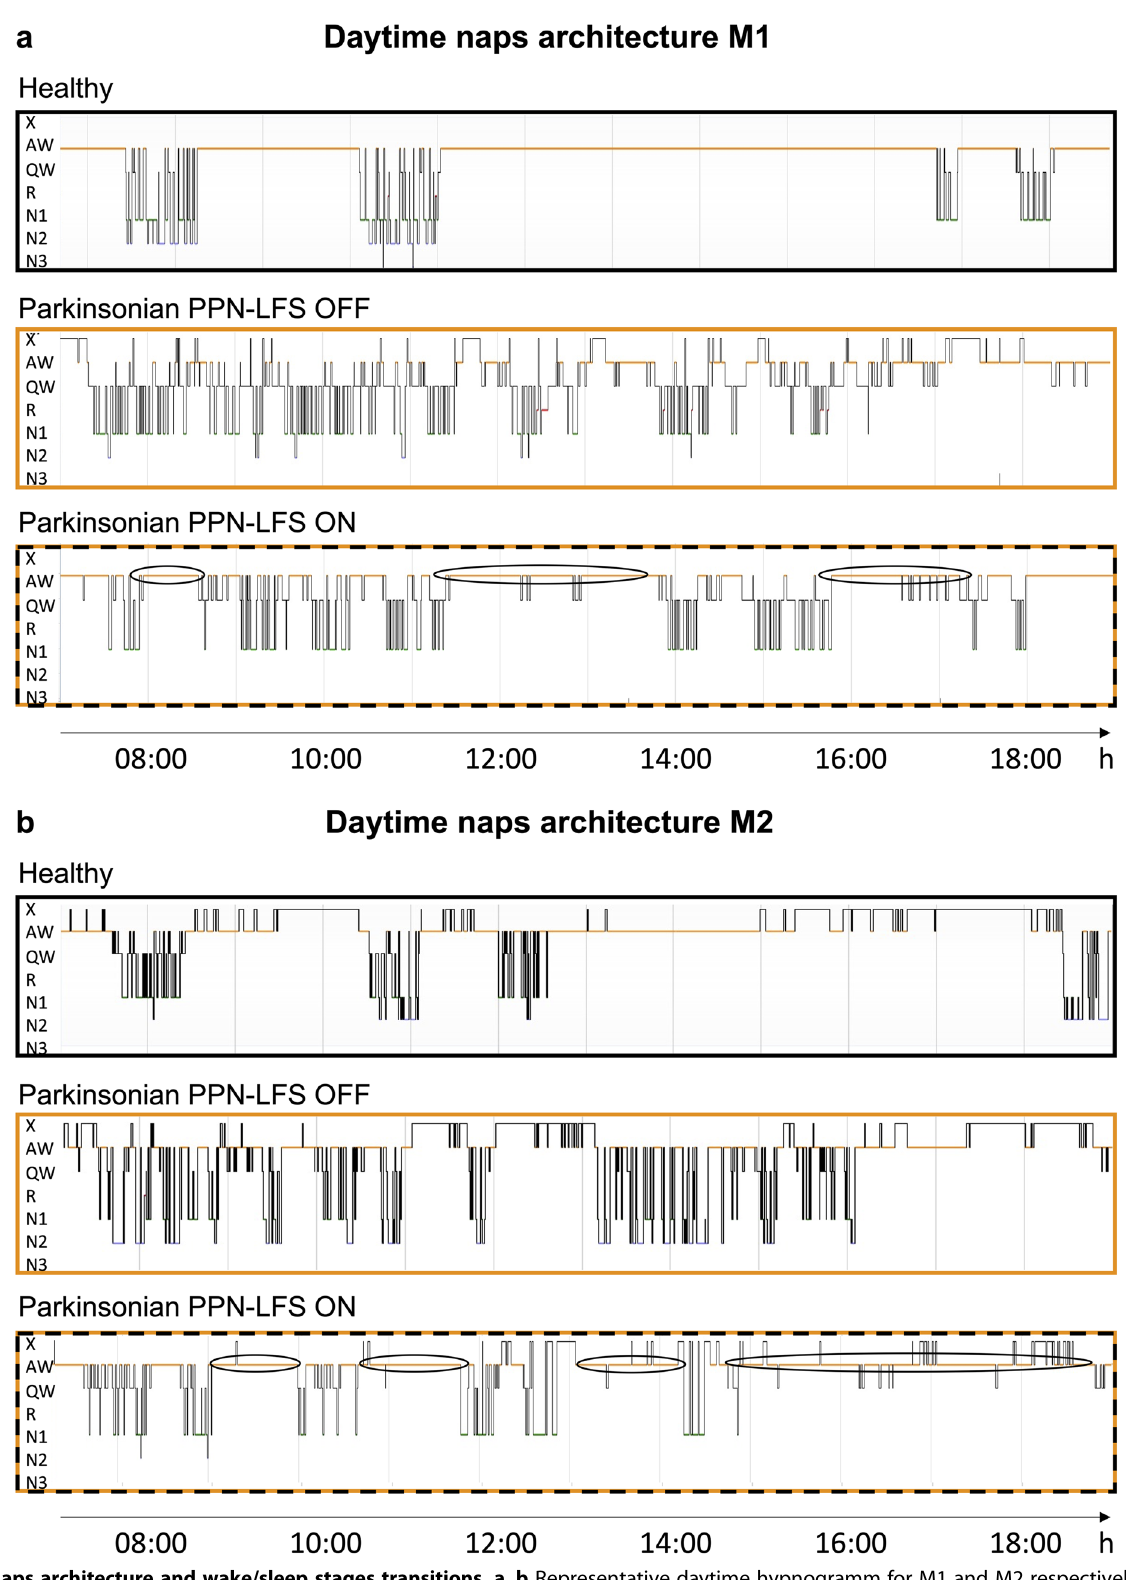
Fig. 3 Naps architecture and wake/sleep stages transitions. a , b Representative daytime hypnogramm for M1 and M2 respectively, during healthy, parkinsonian PPN-LFS OFF and parkinsonian PPN-LFS ON conditions. The line position indicates the sleep stage represented in y -axis, with X = artifacts; A = active wake; W = quiet wake; 1,2,3 = non-REM sleep stage N1, N2 and N3; R = REM sleep. Note the naps disorganization in parkinsonian state with nearly no continuous active wake periods and the reorganizing effect of PPN-LFS with more active wake periods (circled